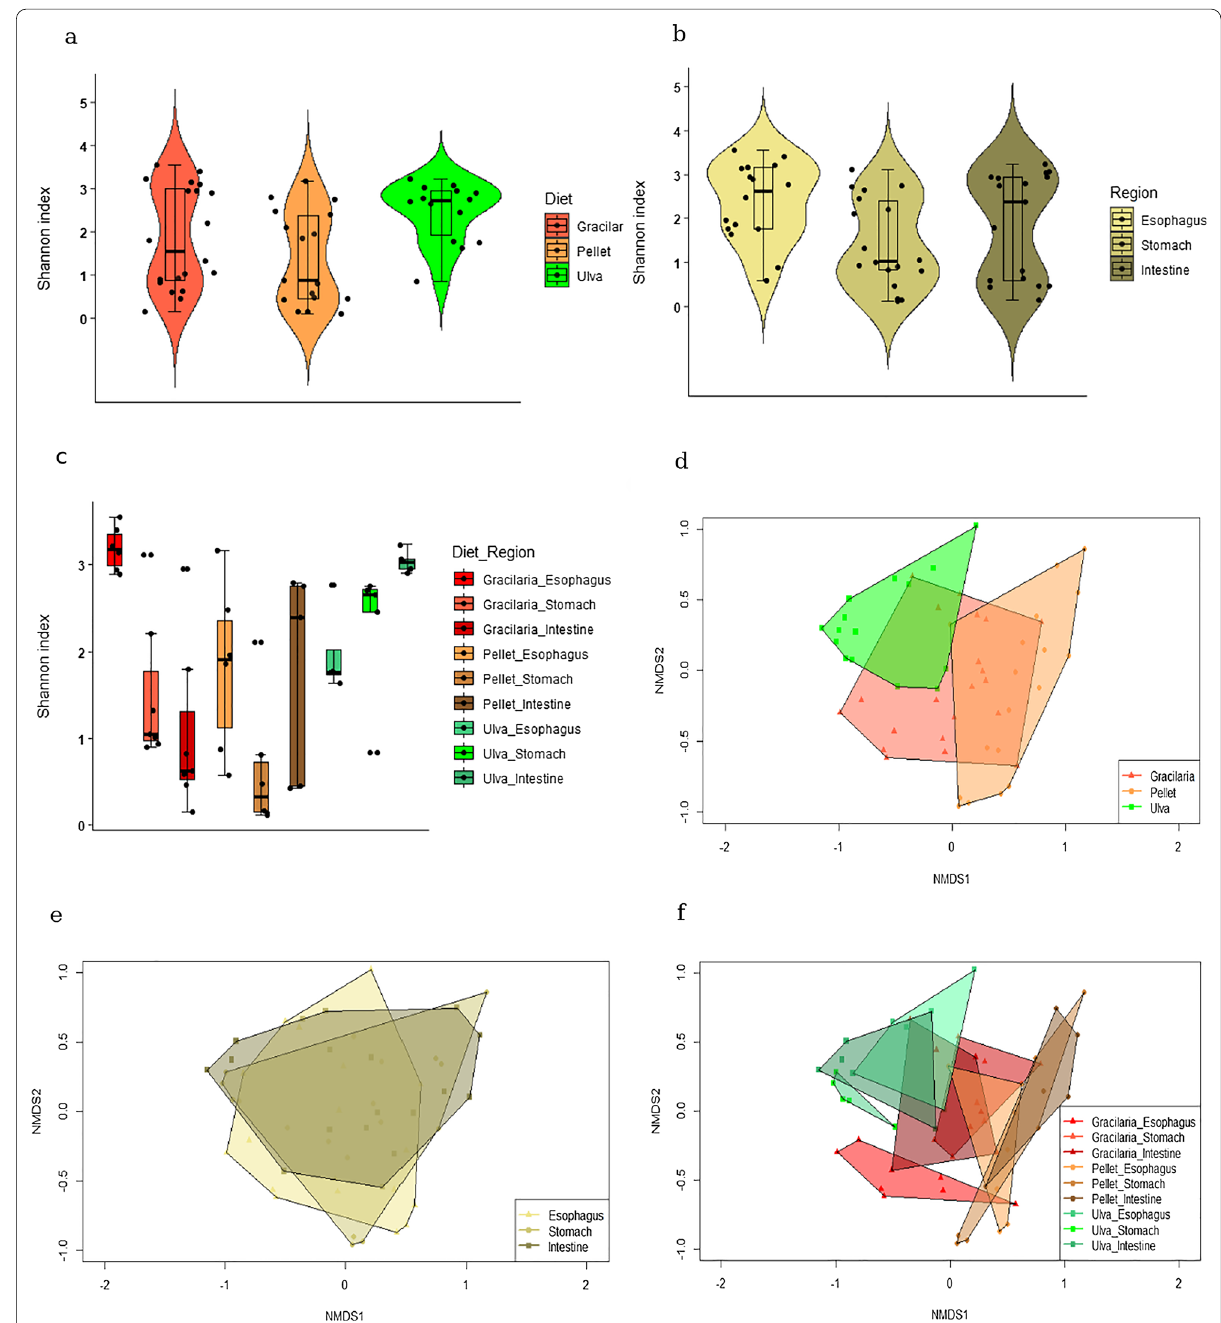
Fig. 1 Richness, diversity and similarity of T. gratilla elatensis GMA under different variables of diet and gut region. Shannon index considering a different diets, b gut regions, or c both variables (n 51). Box plots represent a level of 95% confidence interval, bar plots represent the standard = error, straight lines represent the median, and the black dot represents the mean. Dissimilarity between GMA is demonstrated by non‑metric multidimensional scaling (NMDS) based on Bray–Curtis dissimilarities between GMA in different d diets e gut regions, or f both forces (n